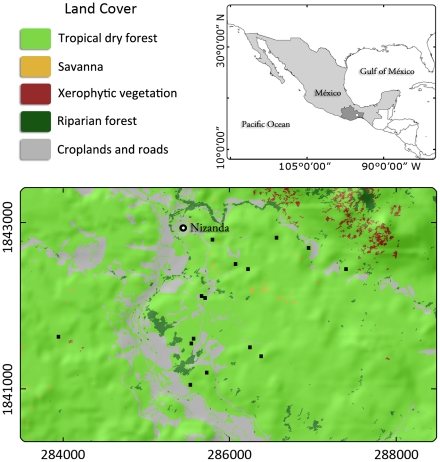
Study area (UTM zone 15n) and location of the secondary plots (▪) used for modeling their attributes from the texture derived from a Quickbird satellite image.